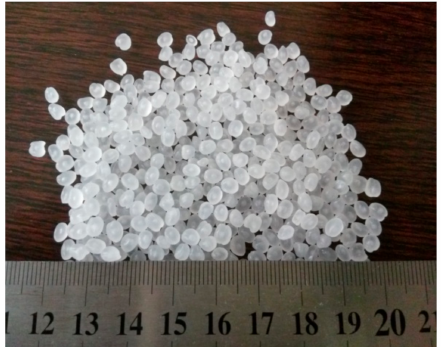
Figure 1. Low density polyethylene (LDPE).